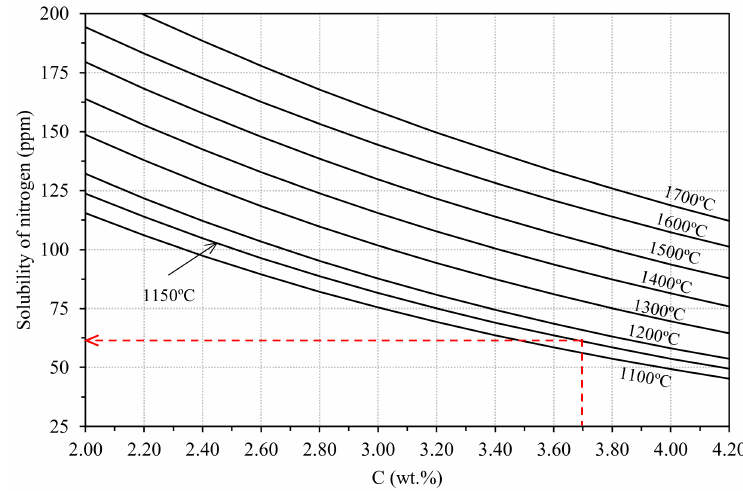
Figure 5. Evolution of the theoretical solubility of nitrogen with carbon content and temperature (Adapted with permission from ref. [7]. Copyright 1979 American Foundry Society).